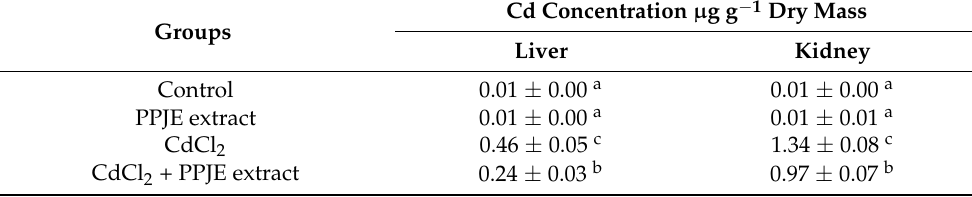
Table 7. Effect of O. stricta juice extract on Cd content in liver and kidney tissues. Control rats. PPJE extract (250 mg/kg)-treated rats. CdCl 2 (1 mg/kg)-treated rats. CdCl 2 + PPJE extract (250 mg/kg)- treated